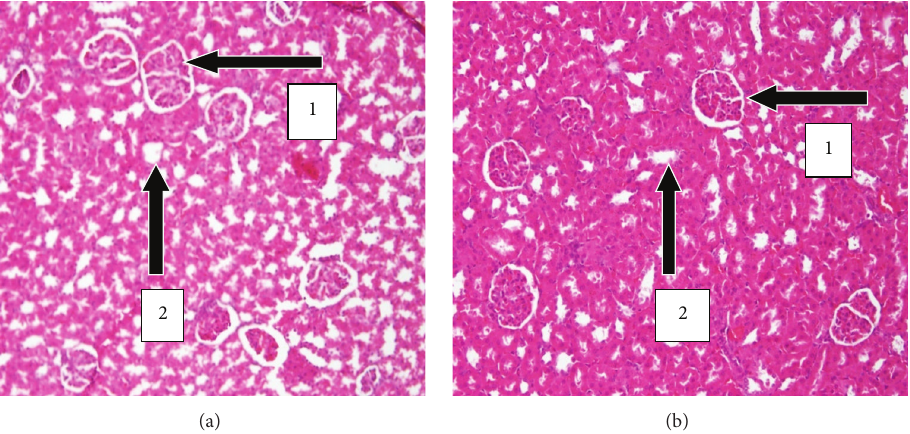
Figure 3: H&E stained sections of kidneys at 20x magnification. (a) Kidney sections of control male SD rats showing normal histology. Note the presence of the glomerular capsule with no necrosis, degeneration, and congestion (1) and normal convoluted tubules with no tubular casts (2) . (b) Kidney section of treated animals (2000mg/kg) with normal glomerulus and renal tubules with no congestion and cellular